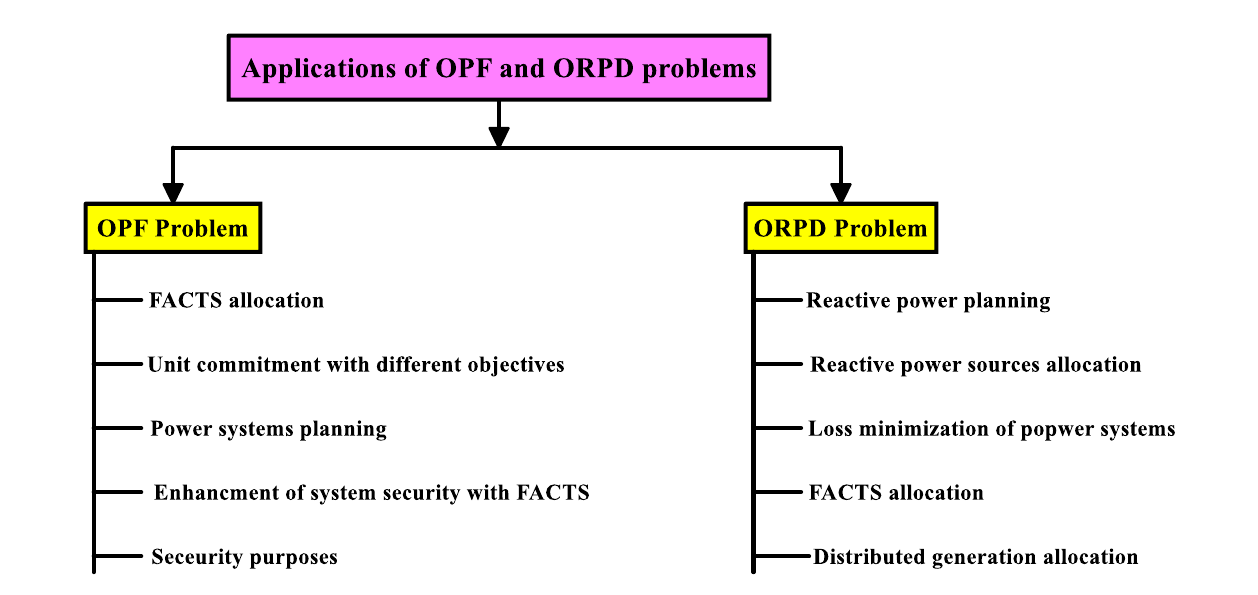
Figure 2. Important applications of OPF and ORPD problems in power systems.